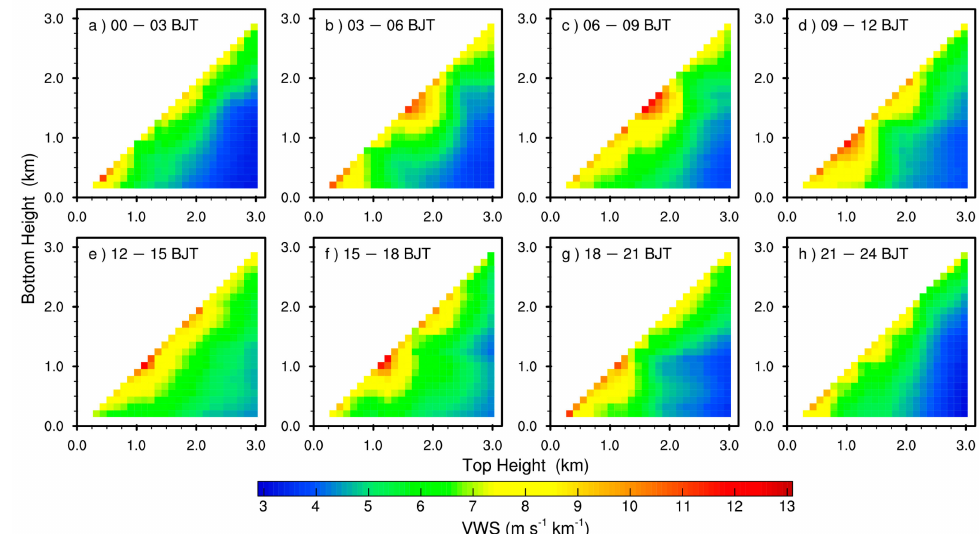
Figure 6. Three-hourly averaged vertical wind shear (VWS) computed between di ff erent heights under polluted conditions in Beijing for ( a ) 0000–0300 BJT, ( b ) 0300–0600 BJT, ( c ) 0600–0900 BJT, ( d ) 0900–1200 BJT, ( e ) 1200–1500 BJT, ( f ) 1500–1800 BJT, ( g ) 1800–2100 BJT and ( h ) 2100–2400 BJT, during the period from December 2018 to February 2019. The X and Y axes represent the top and bottom height of the VWS bulk, respectively.